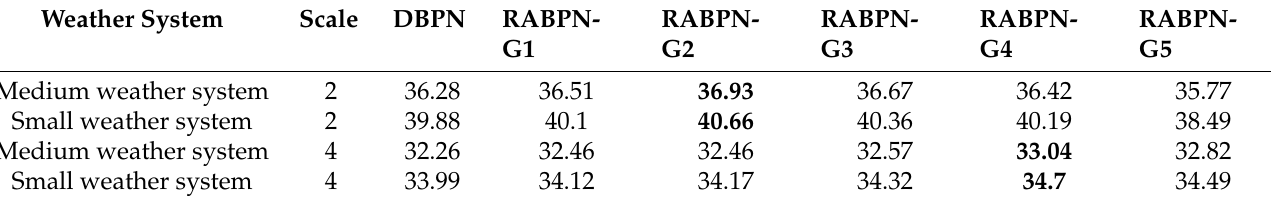
Table 3. The PSNR (dB) value of five RABPN network structures and DBPN.